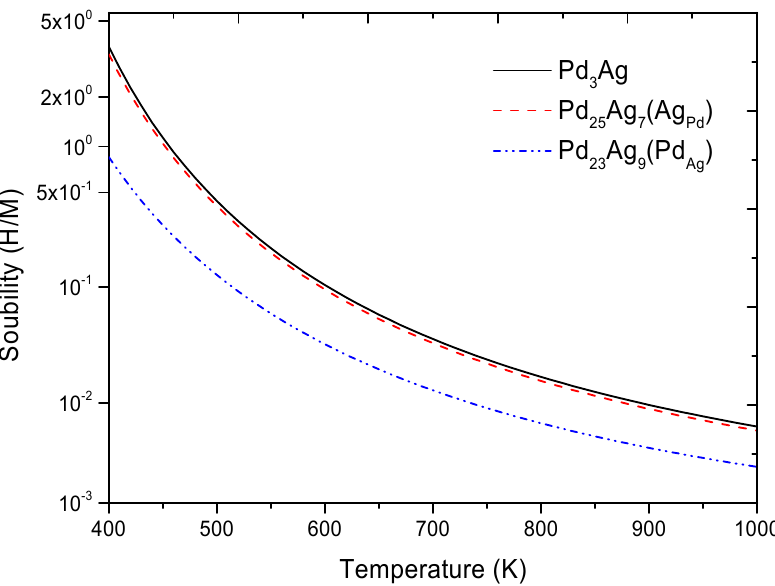
Figure 5. Solubility of hydrogen in L1 2 Pd 3 Ag, Pd 25 Ag 7 (Ag Pd ), and Pd 23 Ag 9 (Pd Ag ) phases.